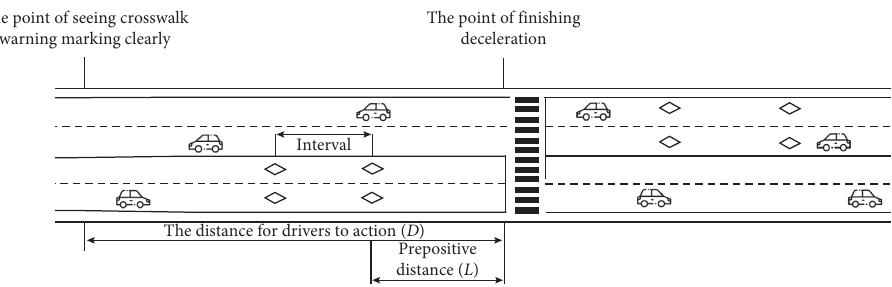
Figure 1: The process of recognizing crosswalk warning markings. Table 1: The calculated value of the prepositive distance.